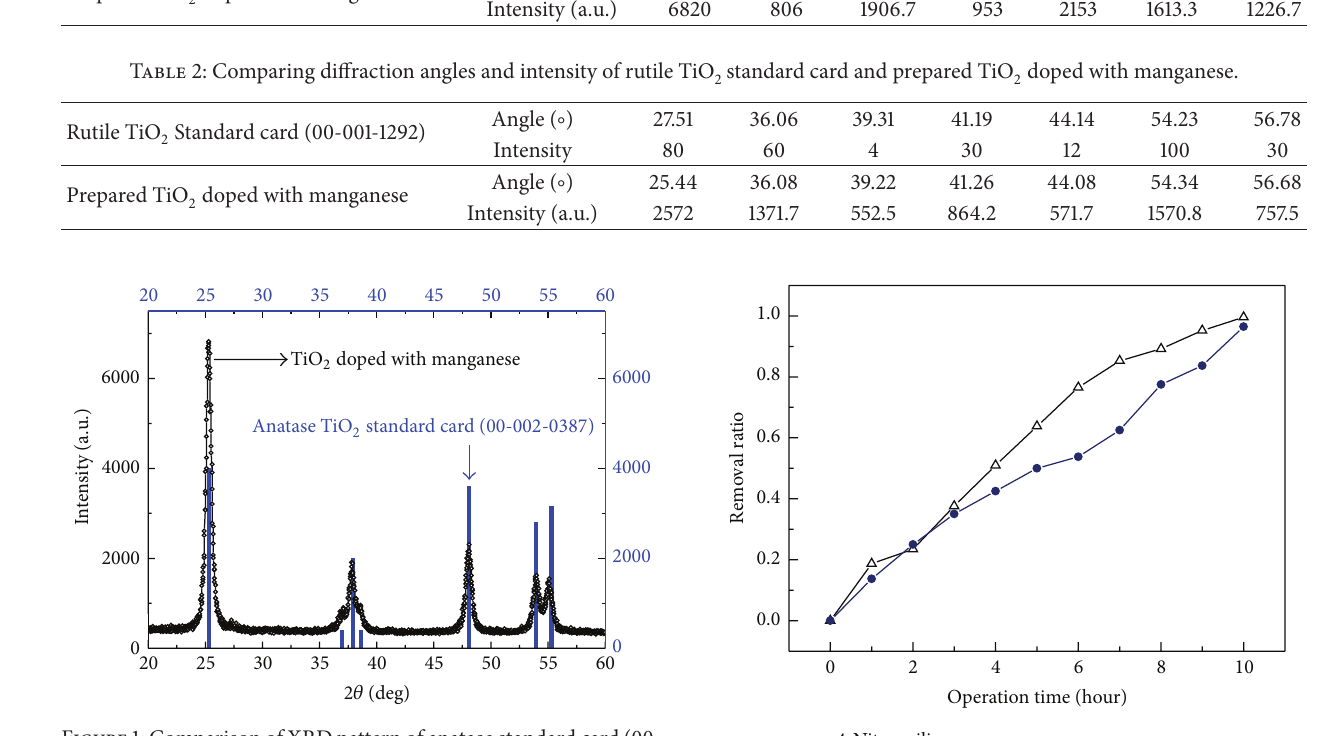
Table 1: Comparing diffraction angle and intensity of anatase TiO Anatase TiO standard card (00-002-0387) 2